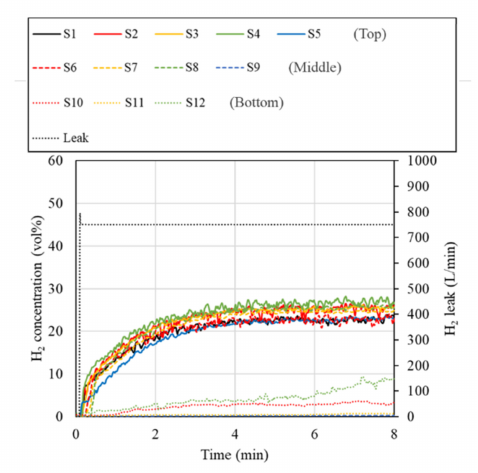
Figure 3. Hydrogen concentration variation by leak (Case 5: hydrogen supply pressure 3 kPa, leak hole 3/8 inch, leak amount 750 L/min, no vent opening, and fully operational fan).